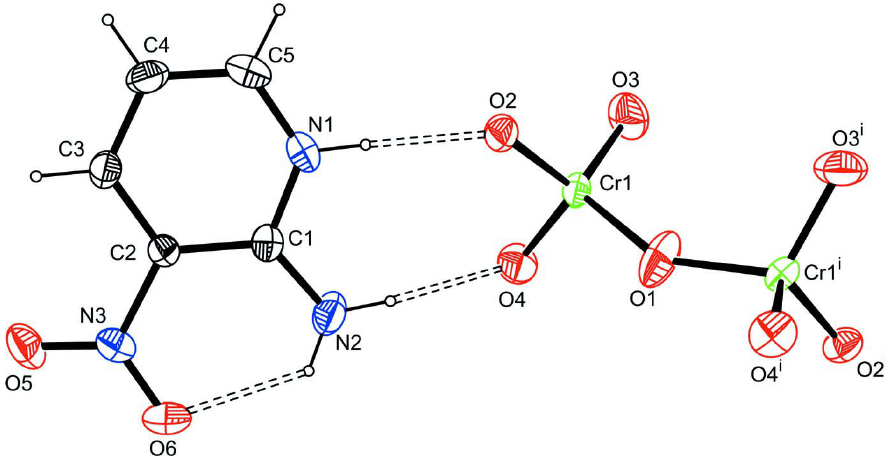
Figure 1 An ORTEP view of (I) with the atom-labelling scheme. Displacement ellipsoids are drawn at the 30% probability level. H atoms are represented as small spheres of arbitrary radii. Hydrogen bonds are represented as dashed lines. [Symmetry code: (i) -x+1, y,